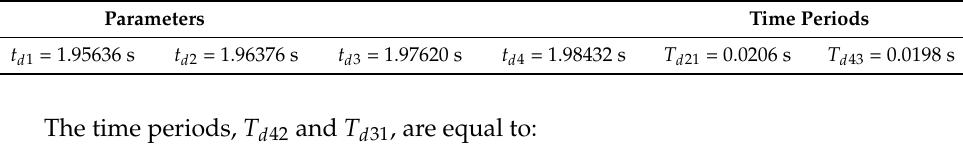
16 of 20 Figure 23. The time graph of acceleration by loaded carriage crossing over the simulated damage: ordinate tick marks: 100 ms − 1 , processed in DeweSoft. The time graph in Figure 24 illustrates the measured acceleration of the vibrations in the time domain at the diagnostic part crossing over the simulated damage. The time pa- rameters of the major ( T